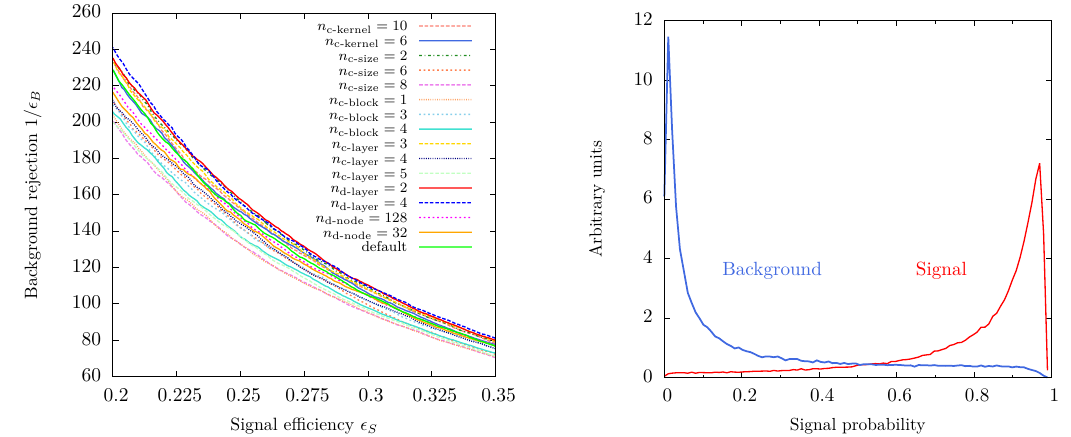
Figure 3 . Left: performance of some of our tested architectures for full pre-processing in terms of an ROC curve, including the default DeepTop network. Right: discrimination power or predicted signal probability for signal events and background probability for background events. We use the default